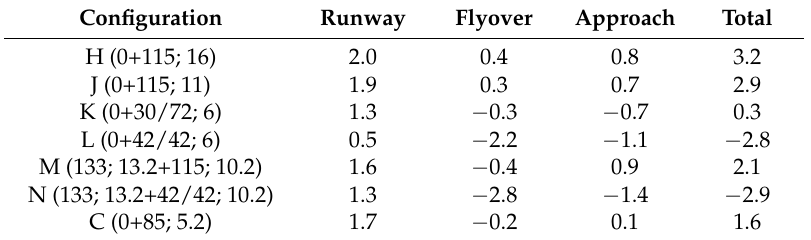
Table 4. Acoustic efficiency of the tested CT configurations installed on the CRTF2A fan model (dB). Configuration Runway